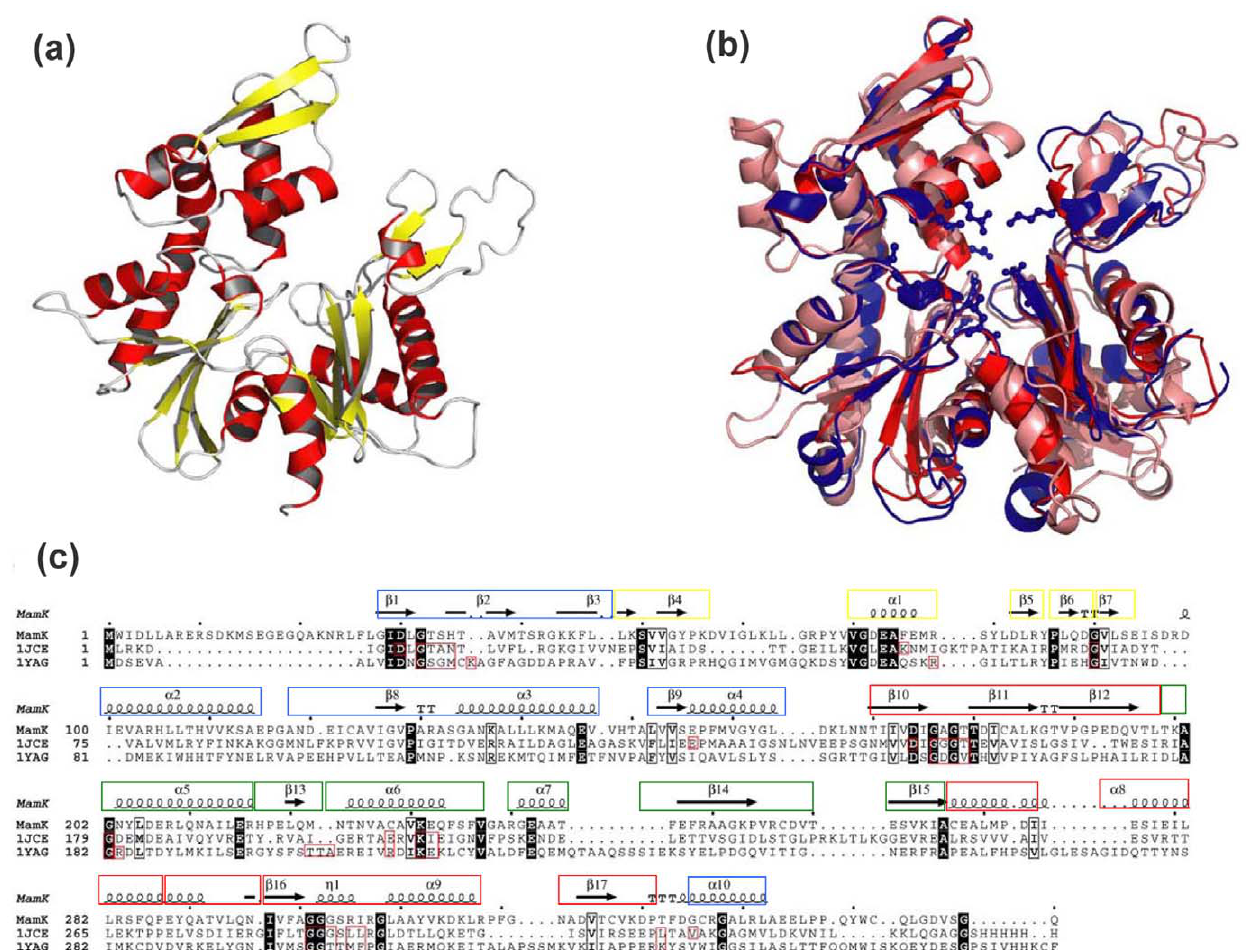
Figure 6. Comparison of the three dimensional and secondary structures of actin and MreB with the predicted structure of MamK. (a) Cartoon representation of the model generated for MamK. (b) Structural superposition of MamK (red), MreB (blue; pdb entry: 1jce) and actin-F (salmon; pdb code 1yag). Those residues involved in nucleotide binding are shown as sticks and balls for MreB. (c) Secondary structural alignment for the three proteins with the active-site residues marked with red boxes as well as the conserved residues shaded in black boxes. The secondary structural elements ( b -strands and a -helices) that correspond to conserved domain regions are boxed in blue and red for subdomains DLI and DLII and the variable regions are boxed in green and yellow corresponding to subdomains DSI and DSII.